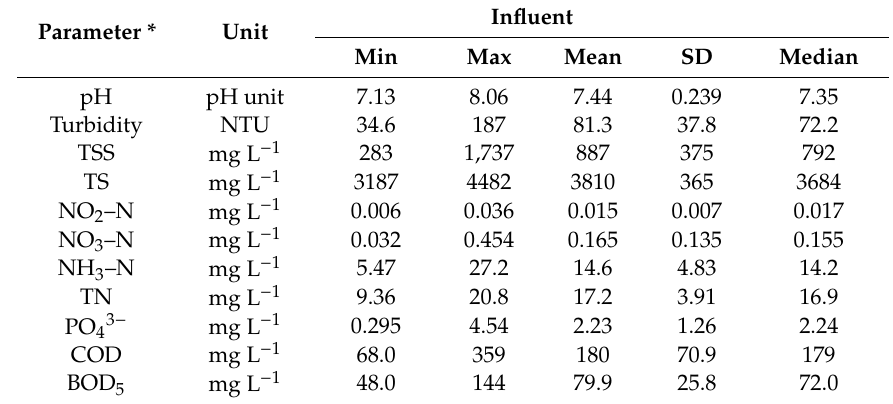
Table 1. Statistical summary of the parameters measured for the influent of the North Sewage Treatment Plant